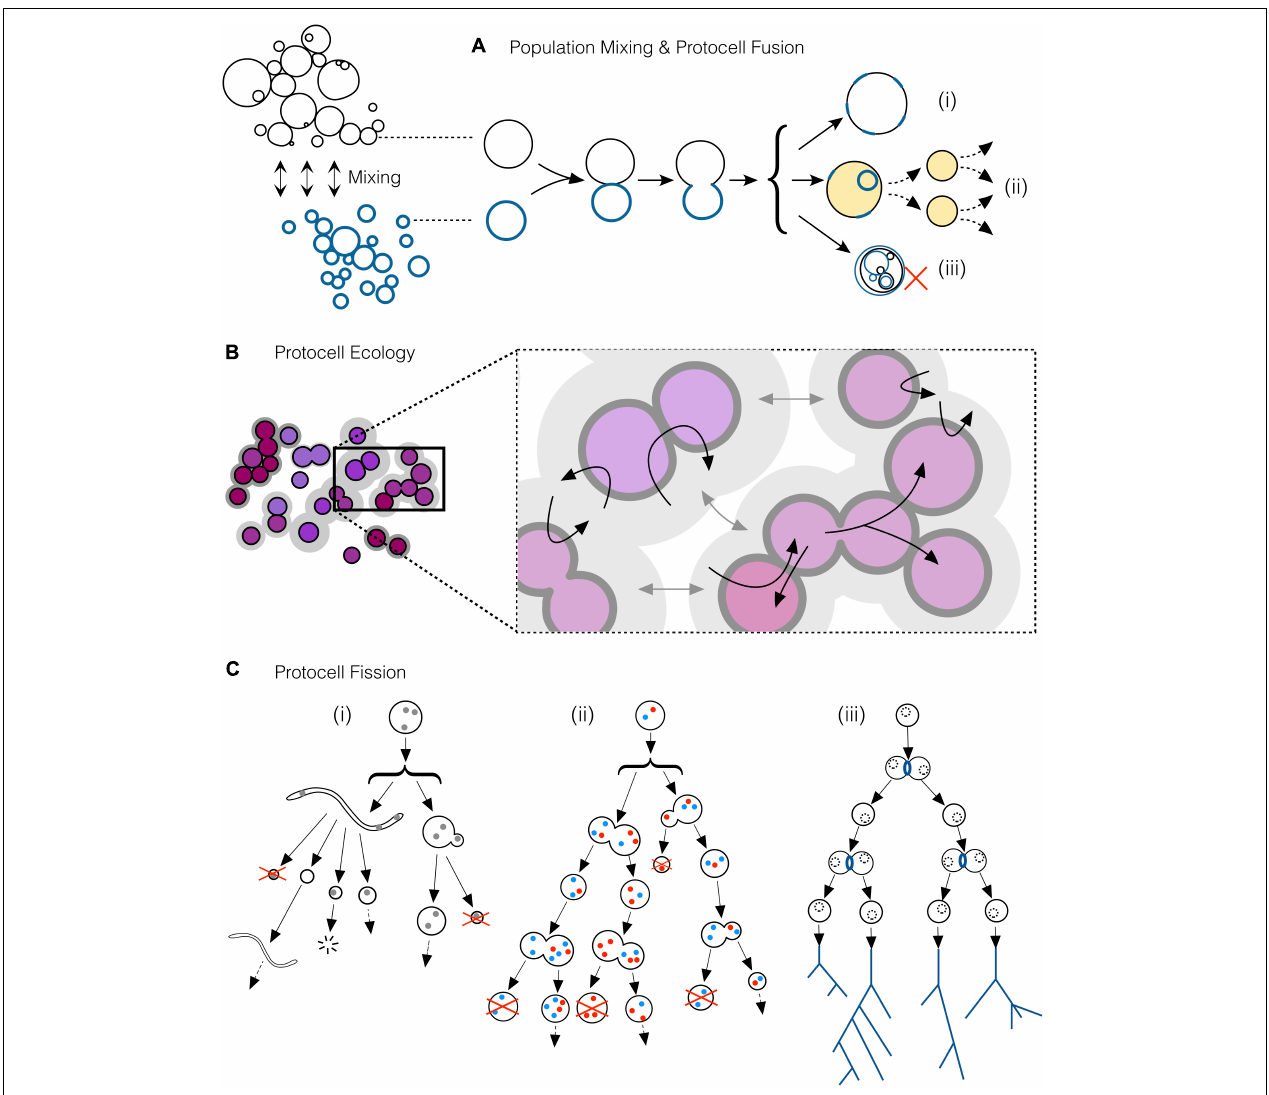
FIGURE 3 | A selection of key processes driving and maintaining the emergence of protocell types in populations of interacting protocells. (A) Mixing of protocell populations, resulting in the fusion of individuals (tokens) from different populations. Protocell fusion would contribute to create (i) new functional tokens, (ii) functional tokens with the potential to become a new type over successive rounds of fission and (iii) novel but non-functional tokens. (B) Ecopoiesis in a population of protocells: synergetic or complementary relationships among members of different sub-populations (e.g., some protocells recycling the metabolic waste of some others) together with niche construction (due to the incipient capacities of these systems to modify their environment) would help in the recycling of limited material resources present in the environment, as well as to maintain diversity in the population composition. (C) Protocell fission via different pathways. (i) At early stages, environmental forces would scaffold the growth and division of simple protocells. (ii) The development of endogenous chemistries synthesizing membrane components would grant protocells the ability start dividing autonomously, but such fission would still be asymmetric and highly irregular during the first stages. Later protocells with more reliable division mechanisms would enter into “reproductive fission,” bringing about increasingly similar daughter protocells at more regular periods. When reproductive fission becomes highly reliable, as depicted in (iii) , natural selection gains importance, reinforcing types in the population and establishing the first “phylogenetic trees” (despite massive horizontal relationships and exchanges among the different protocells, not represented in this